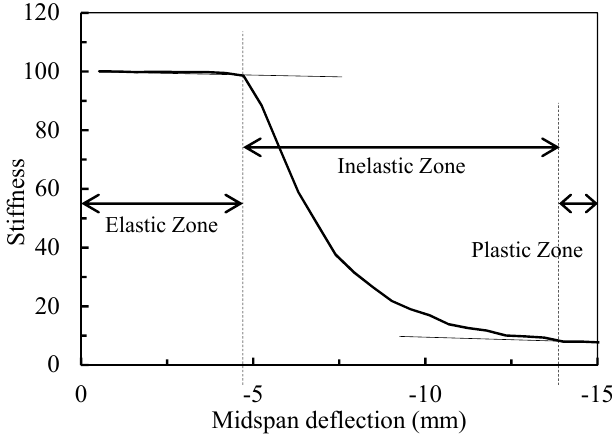
Figure 14. Numerical stiffness–midspan deflection relation of the control beam.